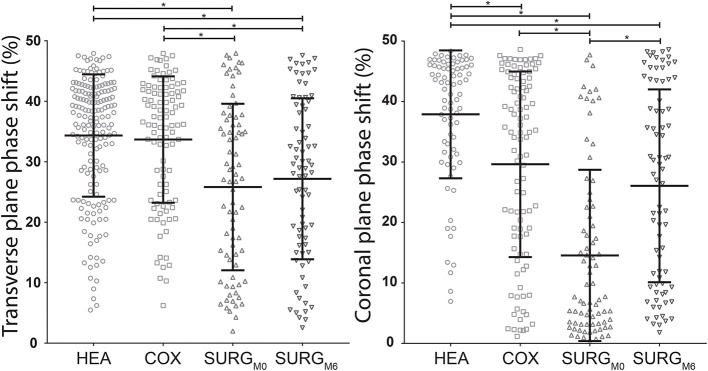
Distribution with mean (horizontal middle bar) and standard deviation (horizontal upper and lower bars) of the transverse and coronal planes phase shifts (pelvis-thorax coordination) during walking in the HEA, COX, SURGM0, and SURGM6 subjects. Significant differences (ANOVA and Tukey) are indicated with a * (HEA: healthy participants, COX: unilateral symptomatic hip osteoarthritis patients with no indication to surgery; SURG: unilateral symptomatic hip osteoarthritis patients undergoing a total hip replacement; M0: 15 days prior to surgery; M6: 6th month after surgery).